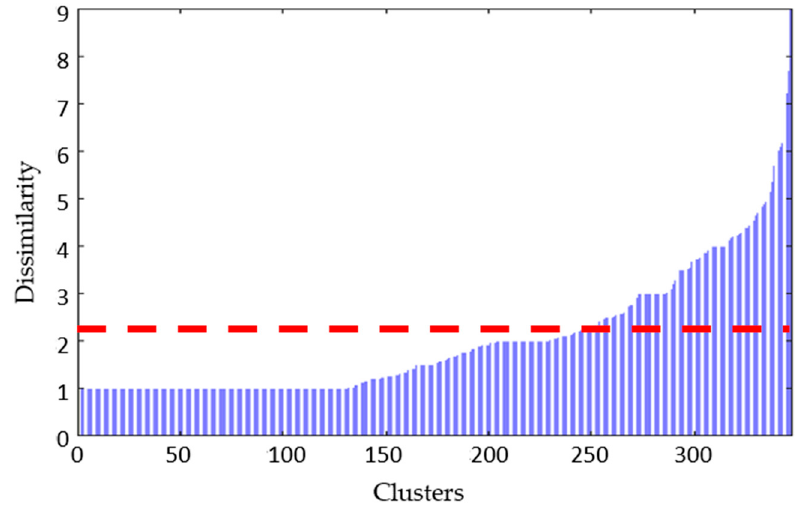
Figure 14. Hamming distance (nubmer of different in input elements).